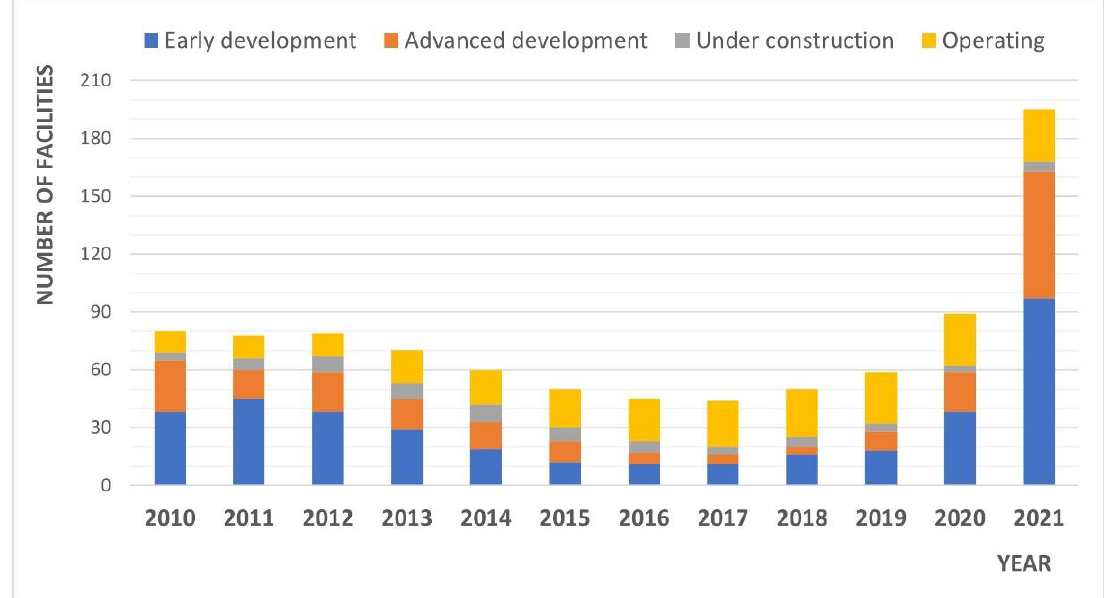
Figure 10. Commercial CCS facilities operating and under development [6,64–67].